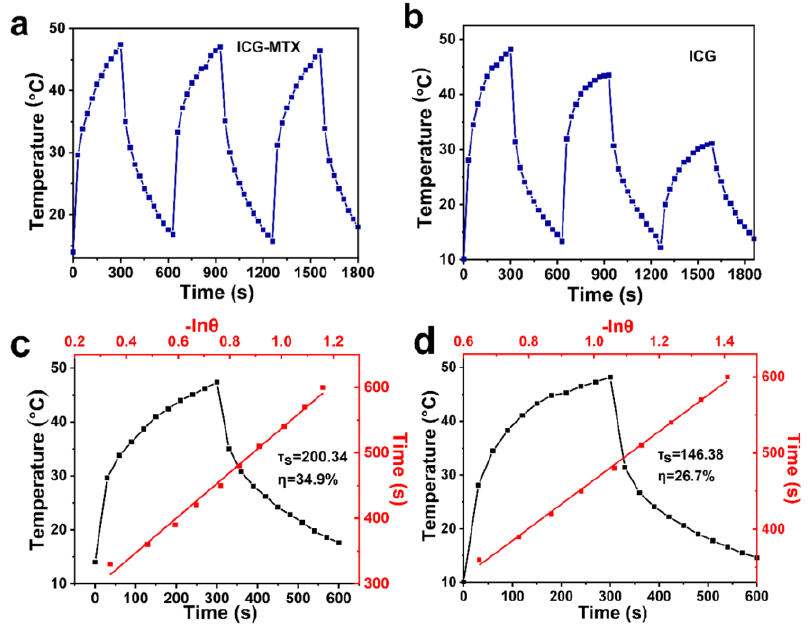
Figure 4. The photothermal stability of ICG—MTX ( a ) and ICG ( b ), and the photothermal conversion efficiency of ICG—MTX ( c ) and ICG ( d ).